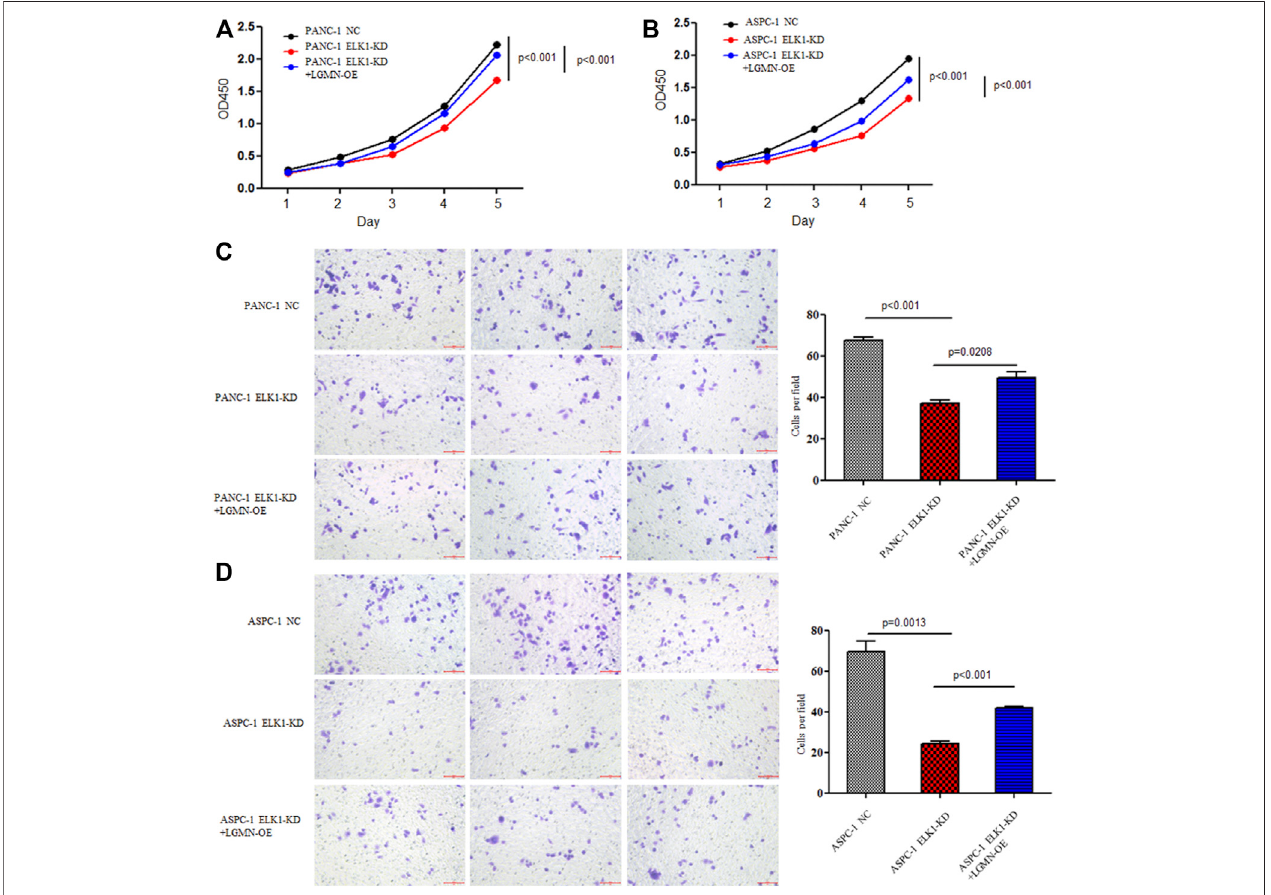
FIGURE 3 | ELK1 promoted pancreatic cancer cell proliferation and invasion via LGMN. (A , B) CCK8 analysis of PANC-1 and ASPC-1 cells with ELK1 knocked downaswellasLGMNrescued.* p < 0.001,** p < 0.001,betweenELK1-KDgroupandcontrolgroup,ELK1-KDgroupandELK1-KD+LGMN-OEgroupinPANC-1cells (A) . * p < 0.001, ** p < 0.001, between ELK1-KD group and ELK1-KD+LGMN-OE group in ASPC-1 cells (B) . (C , D) Matrigel-Transwell analysis of PANC-1 and ASPC-1 cells with ELK1 knocked down as well as LGMN rescued. Five random microscopic fi elds were analyzed for each insert (shown at × 200 magni fi